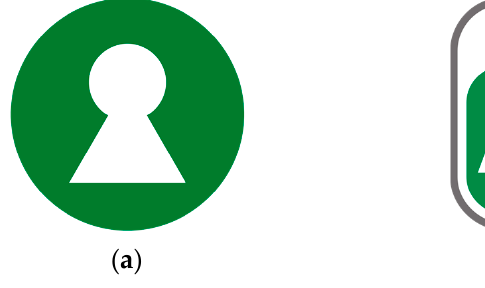
Figure 1. Two front-of-pack nutrition labels (FOPNLs): ( a ) the Keyhole, a positive endorsement FOPNL, owned by the Swedish Food Agency ( Livsmedelsverket ). The Keyhole—which has been implemented in Sweden since 1989, and more recently in Denmark, Iceland, Lithuania, Norway, and North Macedonia—indicates a healthier food option in comparison to foods within the same category; ( b ) the Nutri-Score, a graded indicator FOPNL, owned by Sant é publique France. The Nutri-Score, originating in France in 2017 and more recently implemented in Belgium, Germany, Luxembourg, the Netherlands, Spain, and Switzerland, provides an across-the-board indication of the healthfulness of a food item, with scores ranging from A (high nutritional value) to E (low nutritional